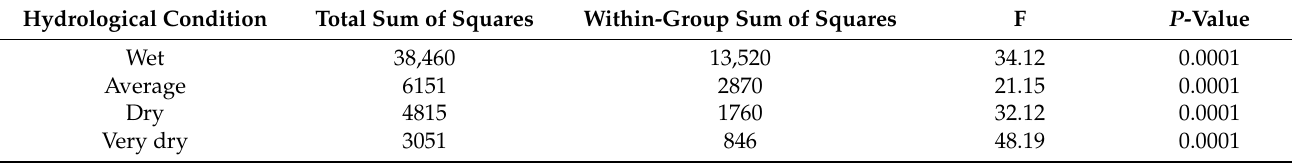
Table 3. Effects of response variables (wet, average, dry, and very dry conditions) between streamflow type and the groups of variability (inter-annual, dry, and wet season) (one-way PERMANOVA). Euclidean similarity index, permutation 9999